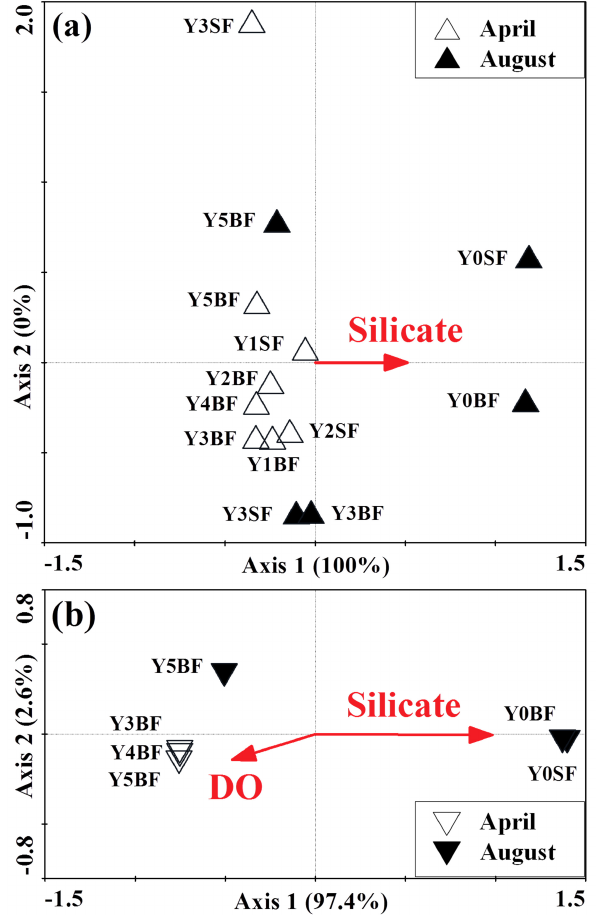
Fig. 11. RDA analysis of free-living β -AOB (a) and AOA amoA - type (b) nitrifying communities. Each symbol represents an indi- vidual sample. Arrows represent statistically significant environ- ment factors explaining the observed patterns ( P = 0 . 001). DO: dis- solved